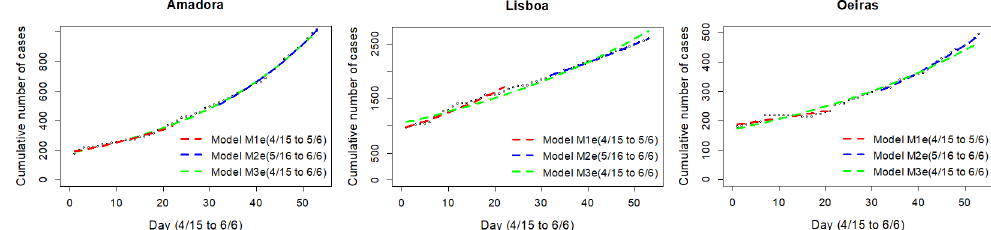
Figure 5. Exponential models fit to S 1 and S 3 periods (red and blue) and to the complete time series